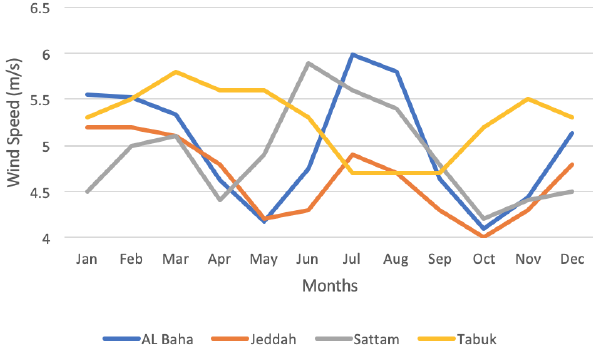
Figure 6: Monthly average wind speed at the selected universities.